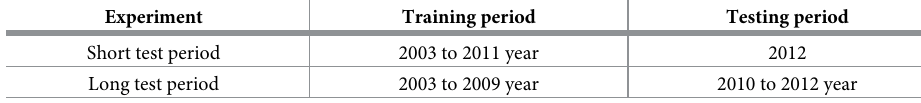
Table 4. The experiment of the long and short test period.